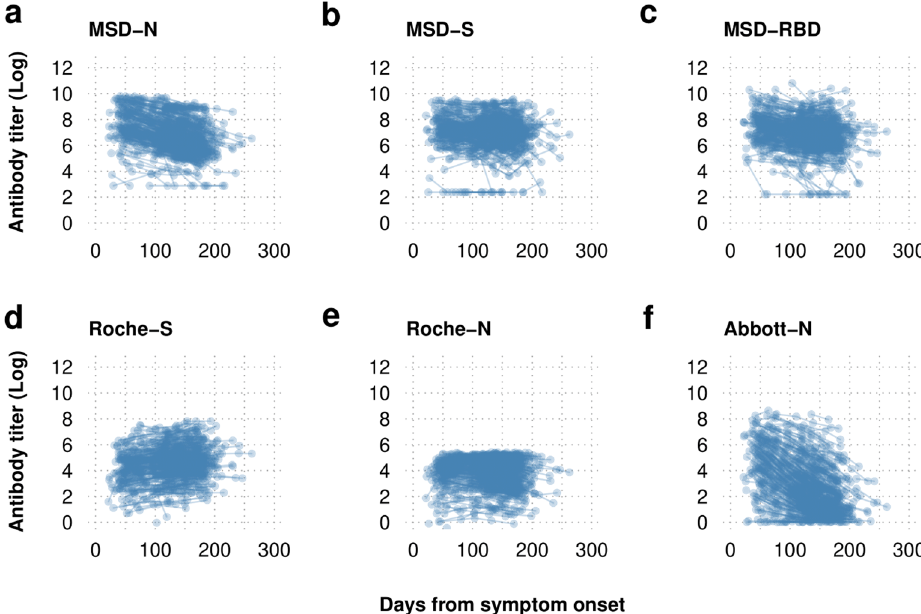
Figure 1. Log transformed serial serological antibody titer data plotted by time from symptom onset. Antibody dynamics are dependent on the assay used with the sensitive Roche-S and MSD-S assay demonstrating maintenance of the spike protein antibody while the nucleoprotein antibody is shown to wane with the MSD and Abbott-N assays but to a lesser extent with the Roche-N